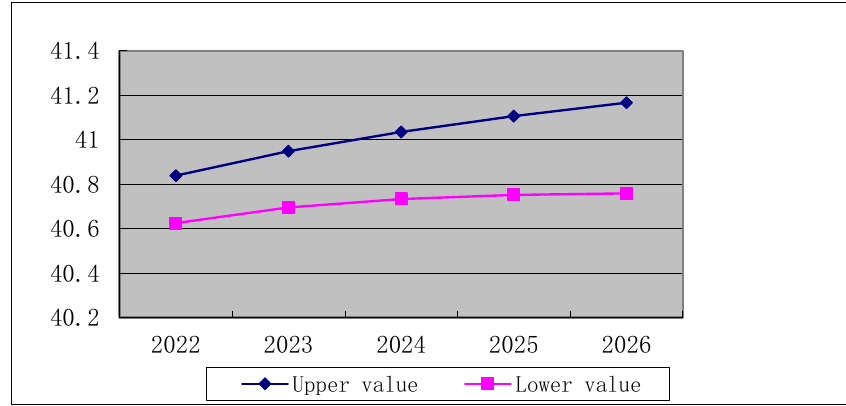
Figure 5. The variation interval of water requirement with the influence of population in Beijing.